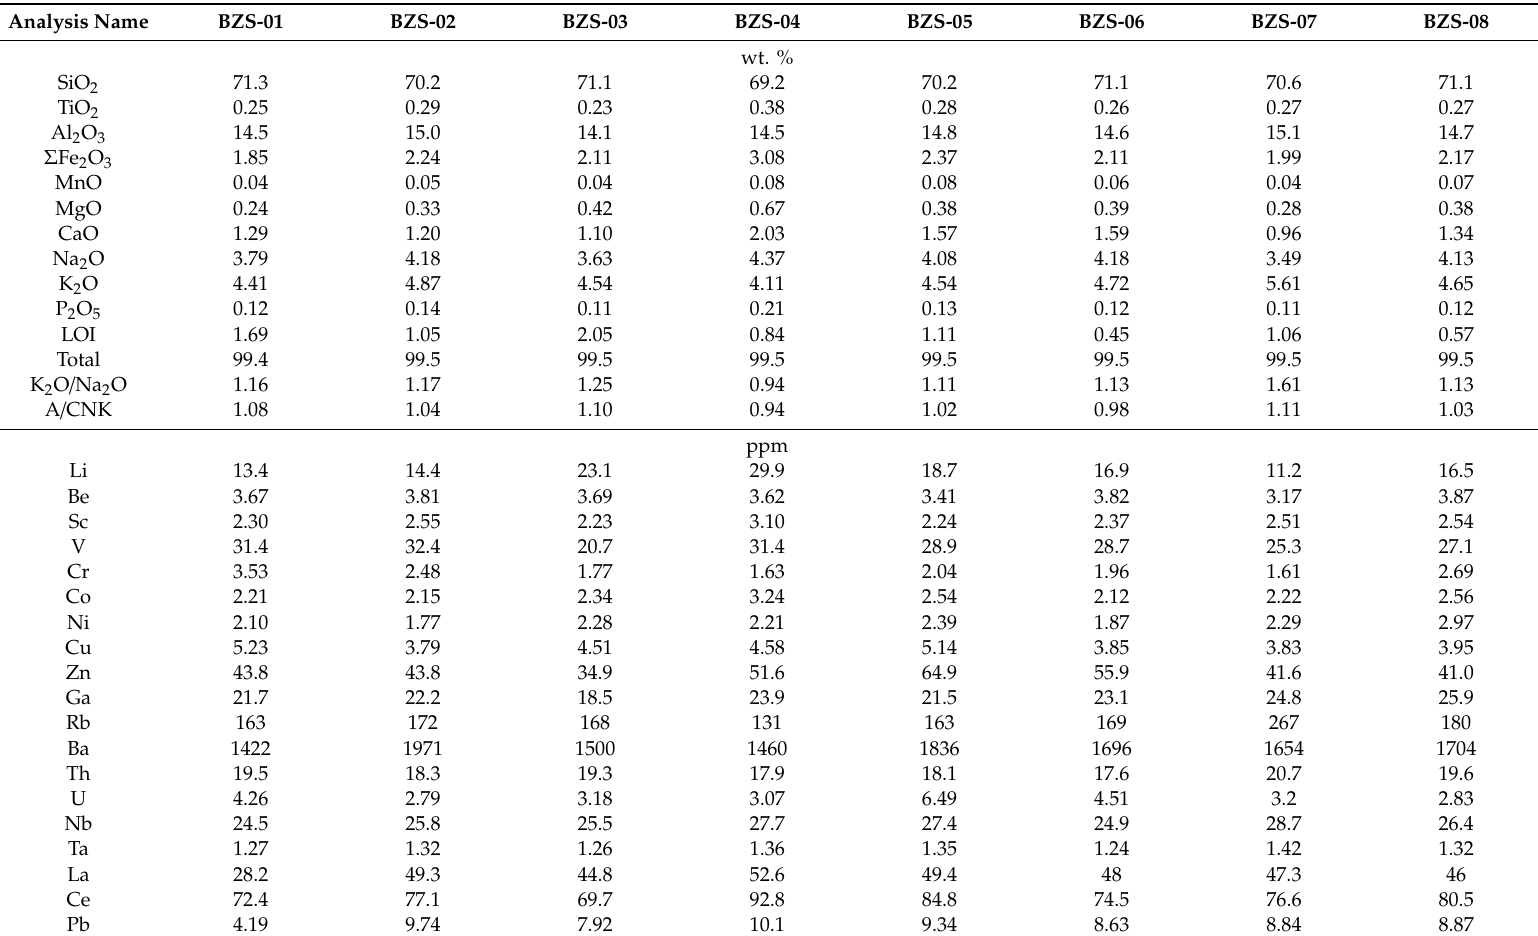
Table 1. X-ray fluorescence whole-rock major oxide and trace element compositions for the Banzhusi granite